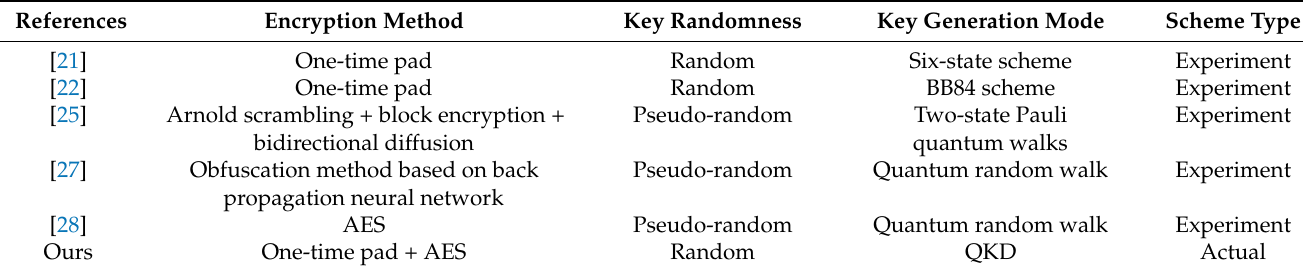
Table 4. Scheme comparison.